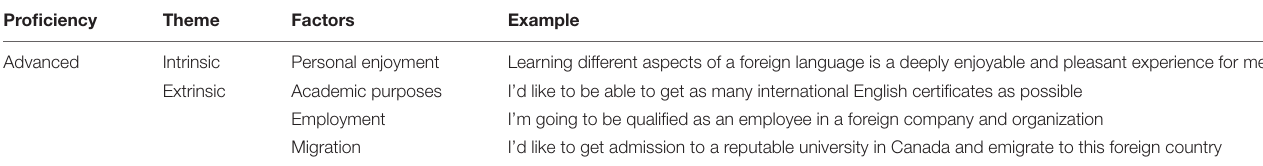
TABLE 7 | Motivational factors influencing advanced EFL learners.